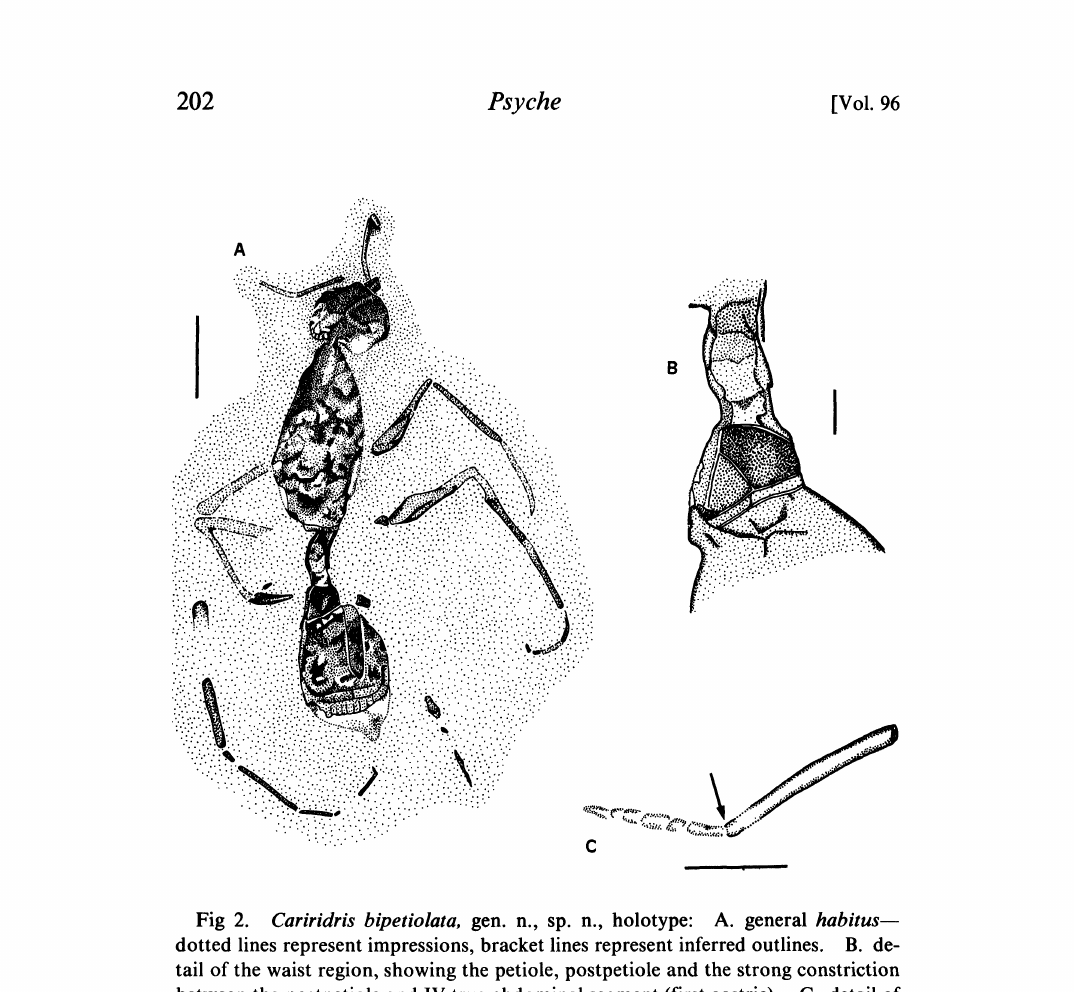
Fig 2. Cariridris bipetiolata, gen. n., sp. n., holotype: A. general habitus-- dotted lines represent impressions, bracket lines represent inferred outlines. B. de- tail of the waist region, showing the petiole, postpetiole and the strong constriction between the postpetiole and IV true abdominal segment (first gastric). C. detail of left antenna (scape at right and preserved funicular segments at left); arrow indicates presumed limit between scape and pedicel. Scales bars for A 2mm, B .5mm and C